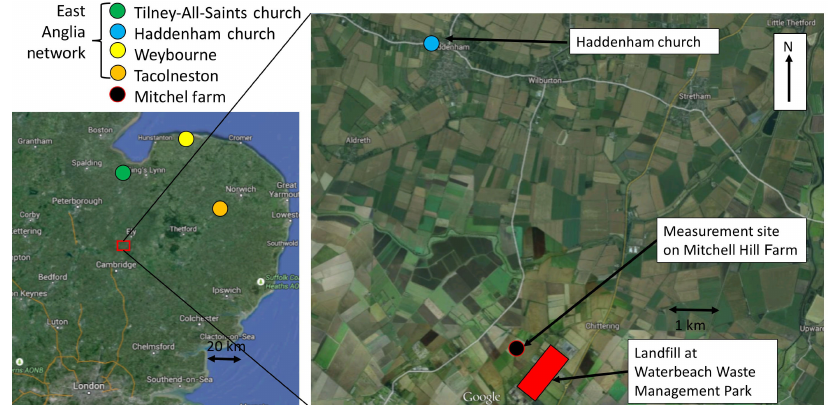
Figure 1. Location of the East Anglia measurement network (Tilney-All-Saints church, Haddenham church, Weybourne and Tacolneston), landfill at the Waterbeach Waste Management Park and the measurement site at Mitchell Hill Farm, Cambridgeshire. The map was retrieved on 23 July 2015 (Google Earth,